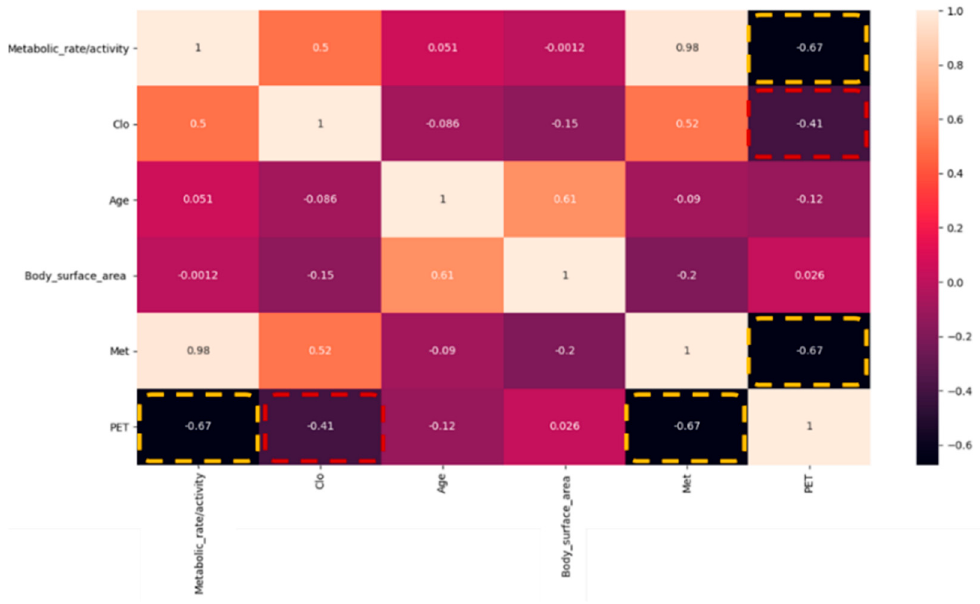
Figure 8. Dependency values between PET metric and factors in outdoor thermal comfort. Table 4. Classification of metabolic rates by activity.